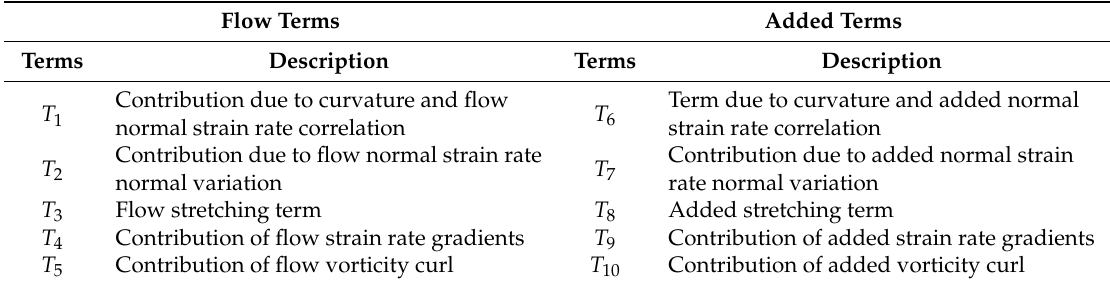
Table 2. Description of the various terms in the curvature transport Equation